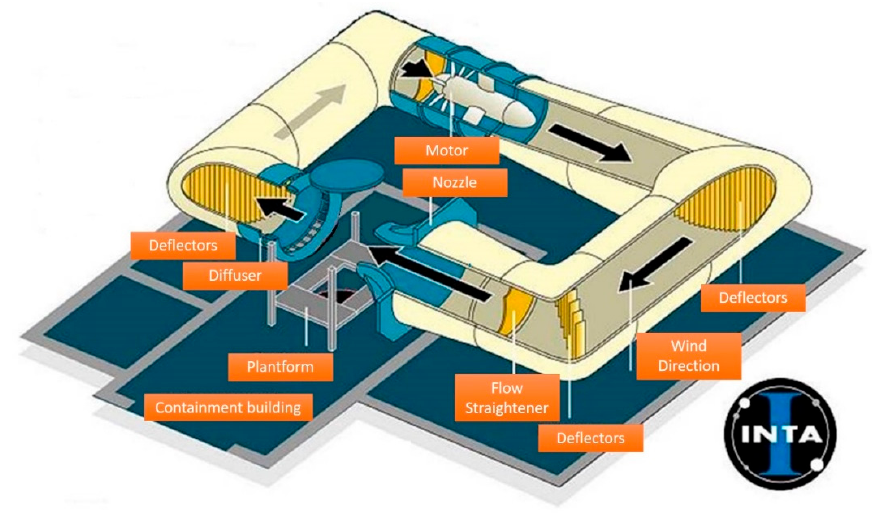
Figure 5. Wind tunnel configuration.